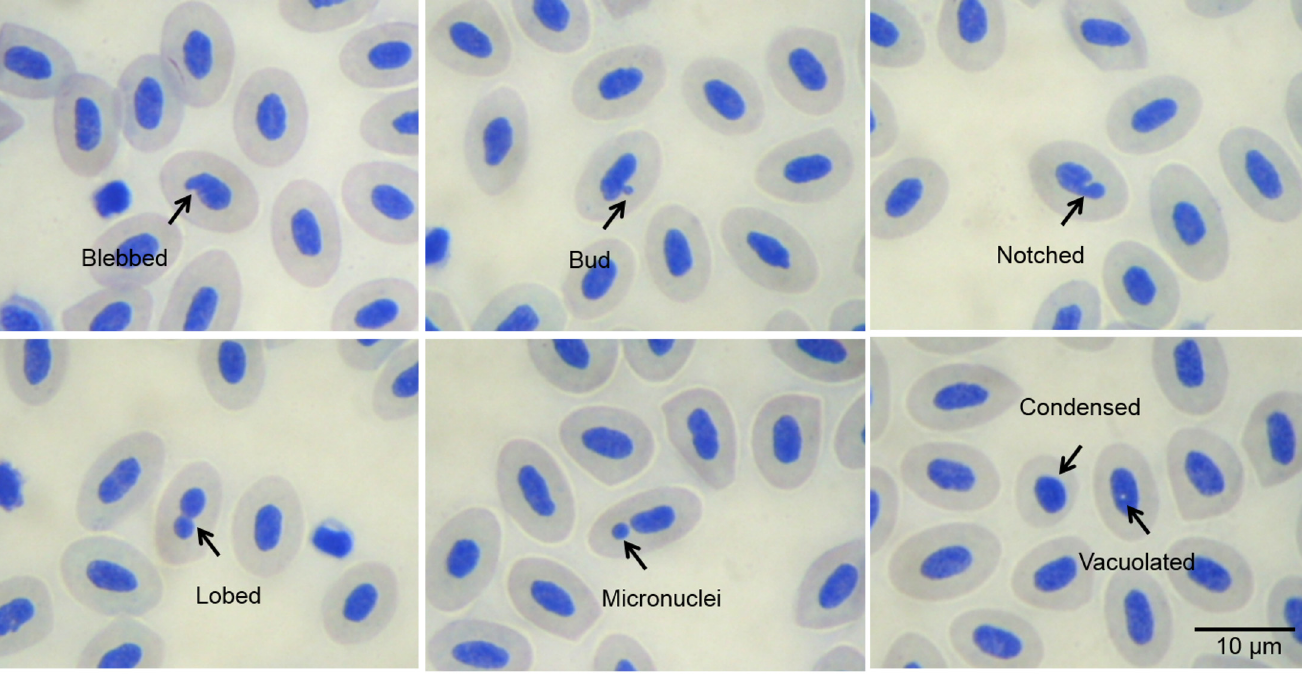
PLOS ONE | DOI:10.1371/journal.pone.0143029 November 30,